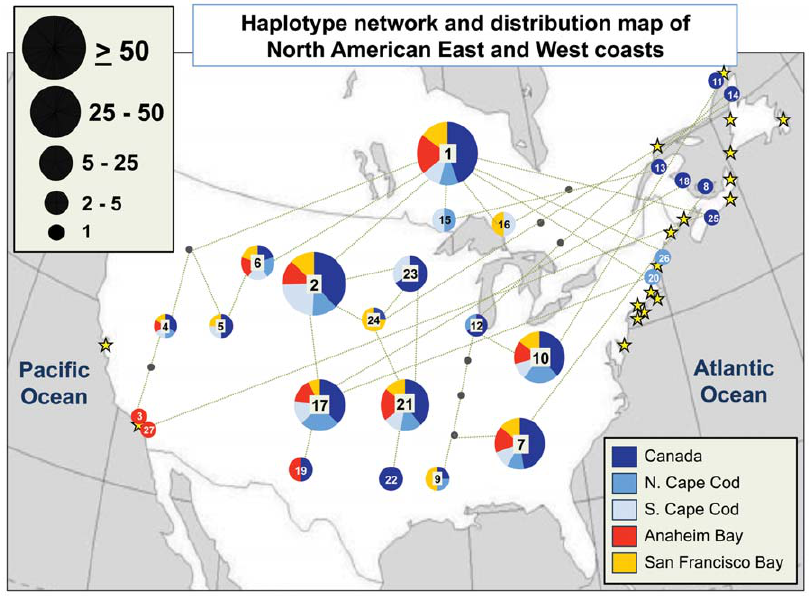
Figure 5. North American Haplotype Distribution Network Map. Yellow stars indicate sampling locations. Each haplotype is represented by a pie chart sized in proportion to its frequency in North American populations (out of a total of 347 individuals analyzed). Numbers on pie charts correspond to haplotype identity as listed in Appendix S1. Colors on the pie charts indicate the geographic distribution (for East Coast subregions and West Coast populations; see legend) of individuals with each haplotype. Lines between pie charts represent connections between haplotypes (based on a TCS 1.21 haplotype network), with the number of line segments indicating the number of sequence changes required to obtain a given haplotype from neighboring haplotypes (dots are intermediate nodes). Pie charts for haplotypes unique to a specific site are shown at that site’s location.